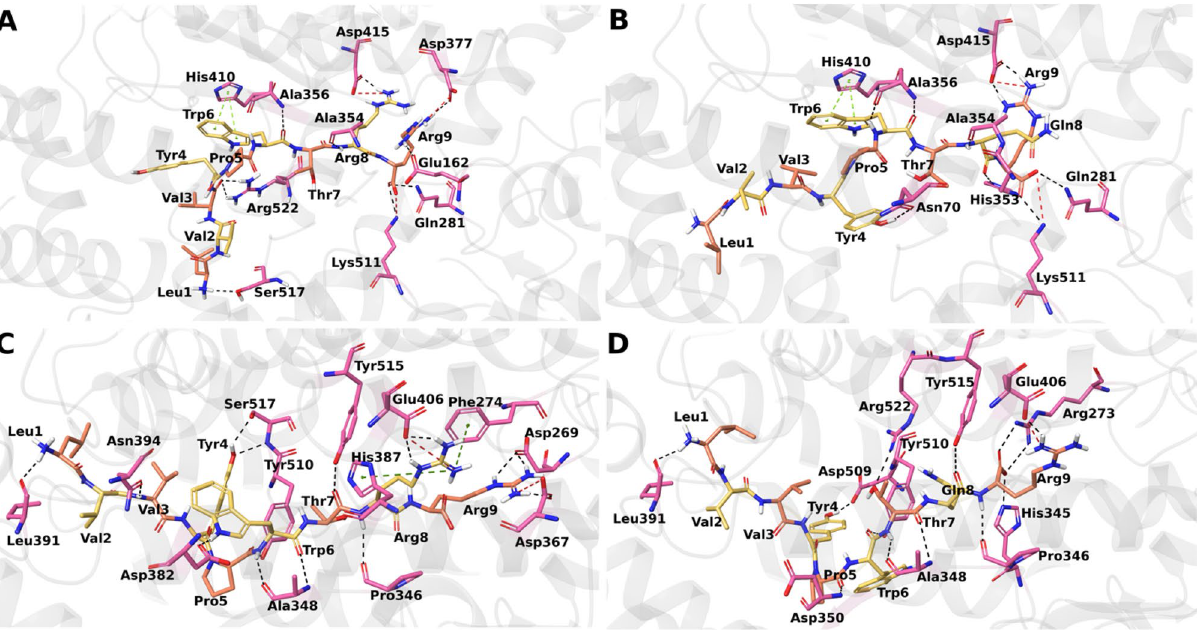
Figure 2. Docked confirmation and hydrogen bond interactions of the hemorphin peptides bound to ACE1 and ACE2. ( A ) Camel LVVHem6 with ACE1 ( B ) LVVHem6 with ACE1 ( C ) Camel LVVHem6 with ACE2 ( D ) LVVHem6 with ACE2. ACE1 and ACE2 are shown in gray cartoon ribbons and their interacting residues are illustrated in a pink stick display; the docked ligand is shown in yellow and orange stick representation, hydrogen bonds are shown as black dashed lines, salt bridges are shown in red, π–π stacking depicted by light green dashed lines, and π-cation stacking is shown in dark green dashed